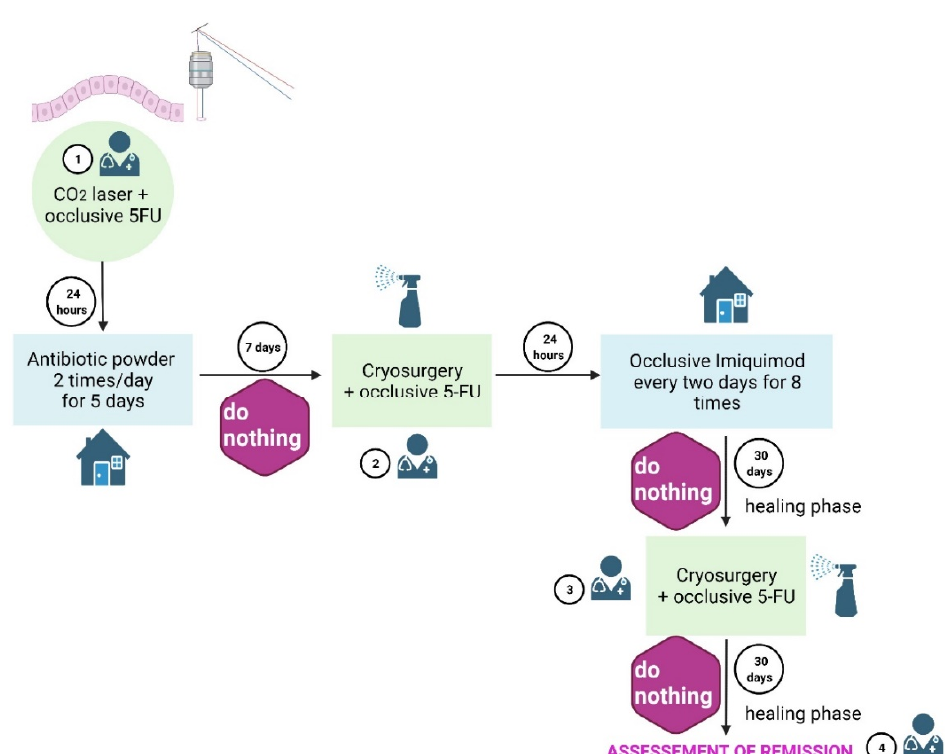
Figure 1. Conservative treatment methodology. This method comprises an initial CO 2 laser ablation, followed by self-application of antibiotic powder, two cryosurgery sessions, three 5-FU chemowraps (after CO 2 laser and cryosurgery), and eight occlusive self-applications of imiquimod. A total of four visits to the physician’s office (including the last one to establish BCC clearance) are required to complete the conservative treatment. 5-FU: 5-fluorouracil.